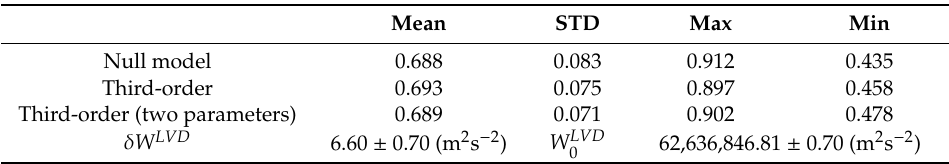
for the VLVD with the global reference level 0